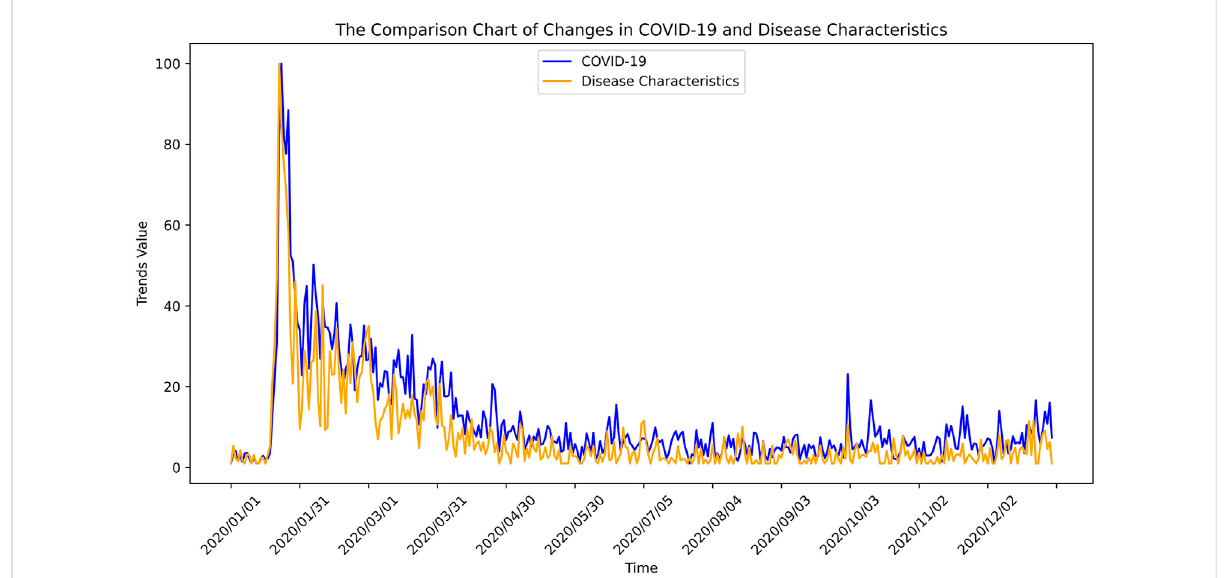
FIGURE 4 The comparison chart of changes in the attention of COVID-19 and disease characteristics.